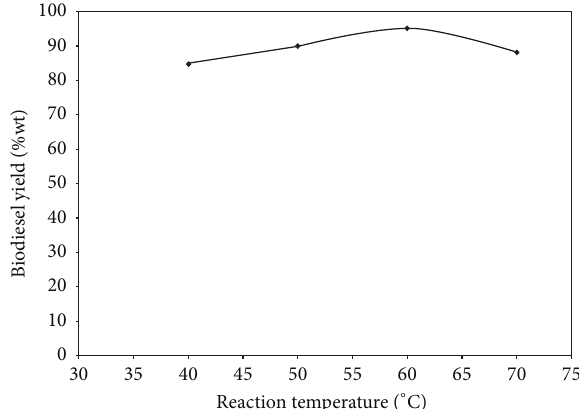
Figure 5: Effect of reaction temperature on biodiesel yield (molar ratio of 6: 1, reaction time of 75 minutes, and catalyst concentration of 0.5 w/w